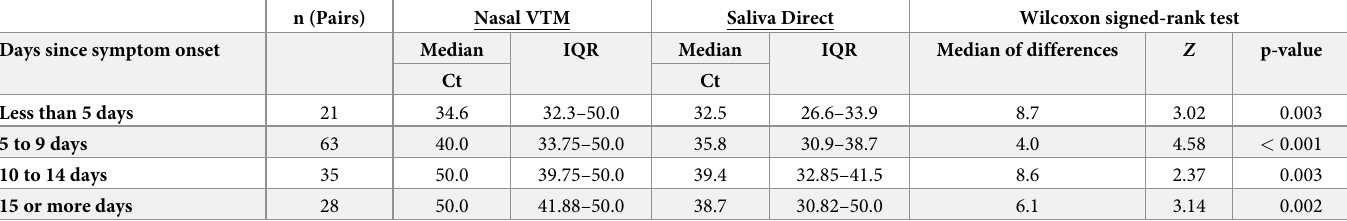
Table 3. Median Ct values of nasal and saliva specimens stratified by days from symptom onset, and results from the Wilcoxon signed-rank tests for the overall analysis cohort.